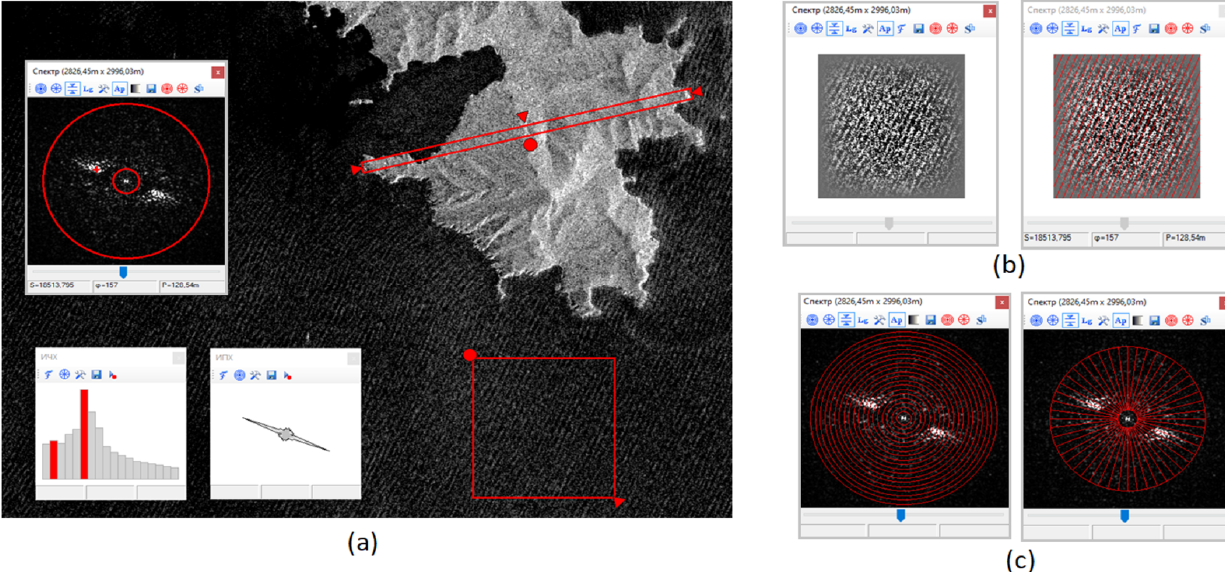
Figure 7. Spectrum tool. Аnalysis of the satellite (Sentinel-2) radar image, 25 September 2020 (Sentinel-Hub EO Browser used). ( a ) the image with selectors, the spectrum, IFC and ISC plots; ( b ) a fragment of source image without and with overlapping wavefronts; ( c ) IFC and ISC calculation schemes.